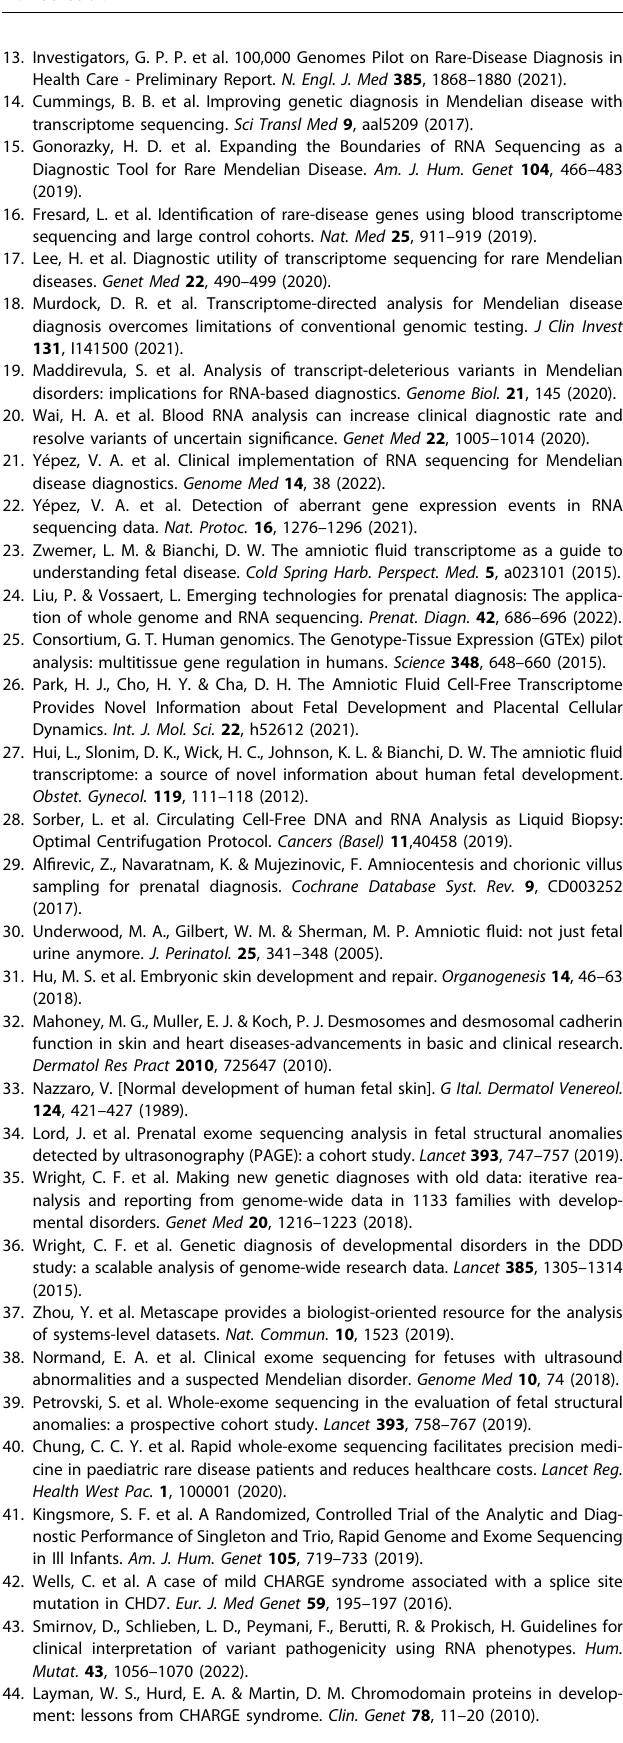
Table 2) spanning the targeted exons were designed to validate the molecular consequences of these splicing variants.